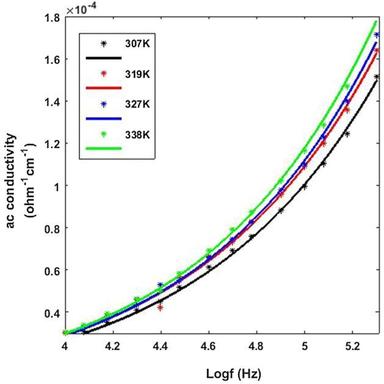
Frequency dependence of AC of PCOH crystal at different temperatures.